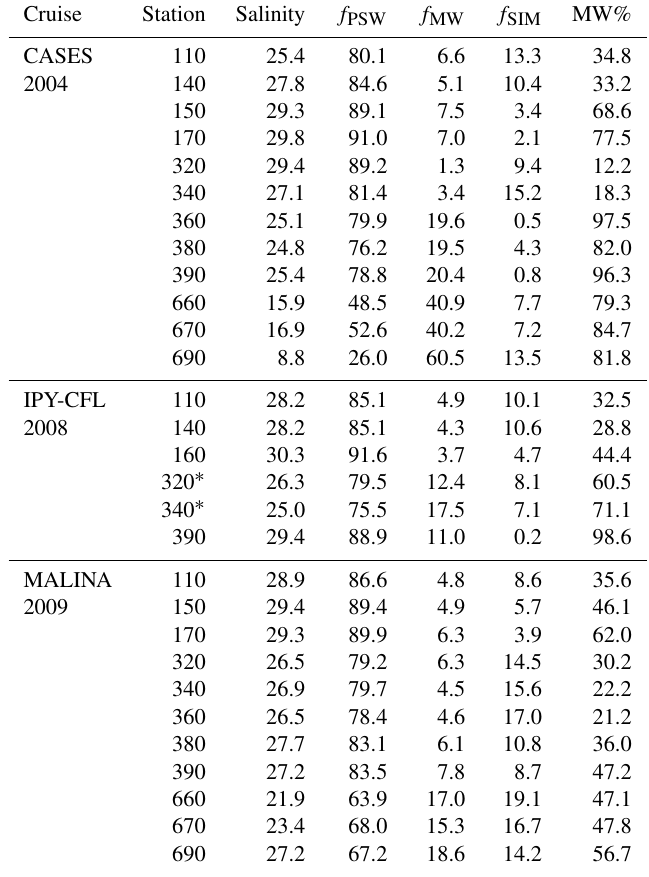
Table 1. Salinity, saline end member, meteoric and sea ice melt fractions (%), and meteoric water percentage of freshwater content (MW% = f MW /(f MW + f SIM ) × 100) for surface seawater samples obtained at matching station locations during CASES 2004 and MALINA 2009. A few matching stations were also sampled during IPY-CFL 2008. The samples were collected with Niskin bottles on a CTD rosette. The fraction of the saline end member ( f PSW ) represents Pacific Summer Water with a salinity of